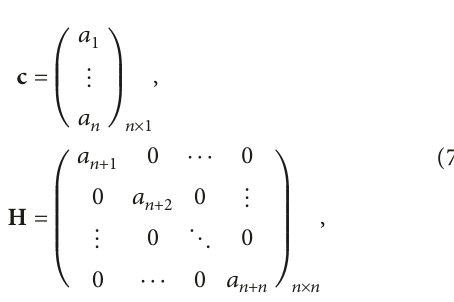
Table 4: Sample points and vibration acceleration